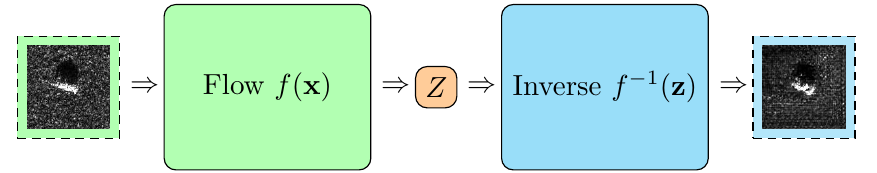
Figure 7. The schematic diagram of